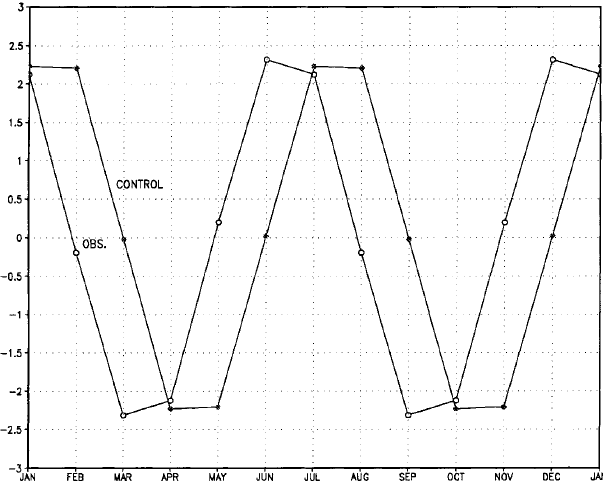
Fig. 2. Mean annual cycle of the second harmonic of the zonally averaged intensity of the subpolar trough from observations and the model